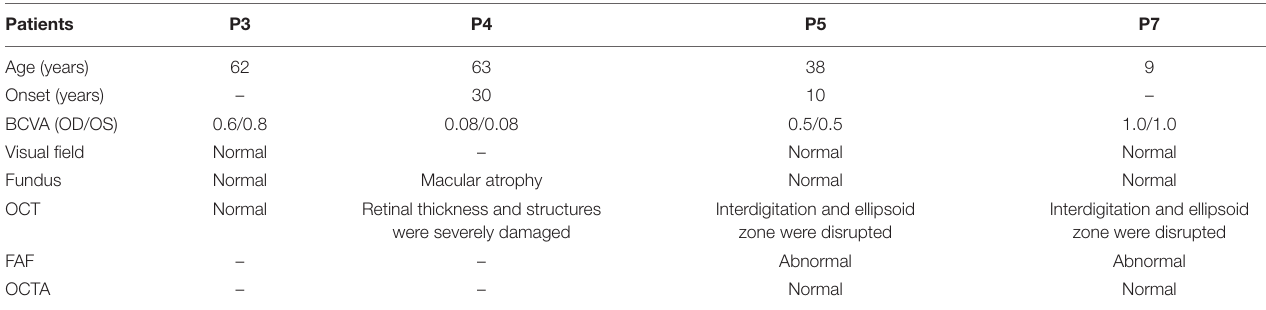
TABLE 1 | Clinical characteristic of